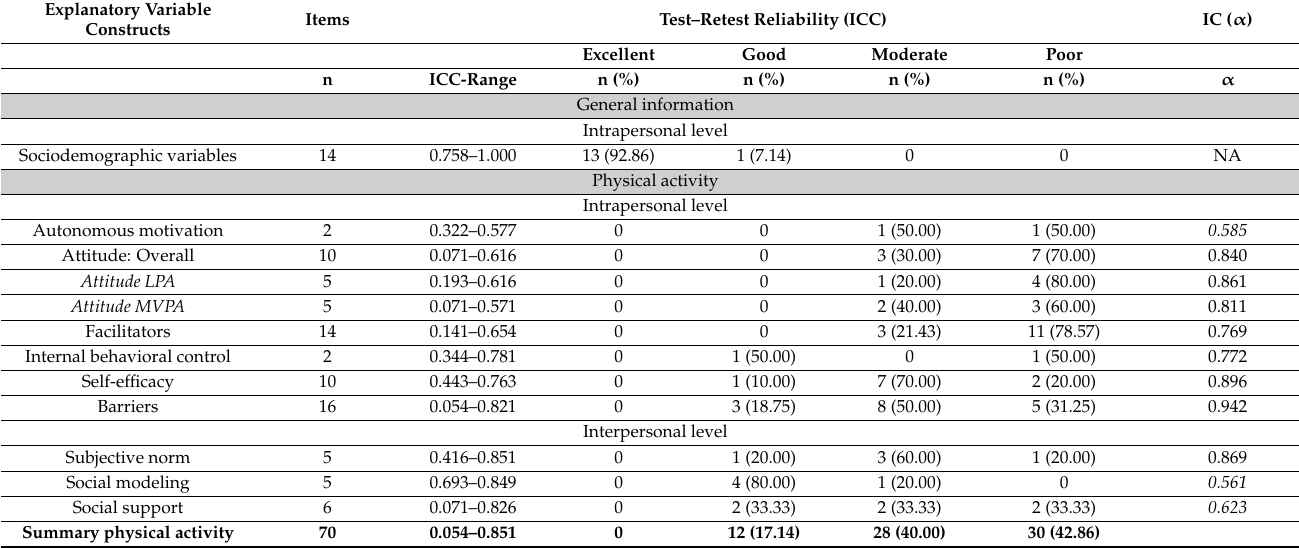
Table 2. Summary of test–retest reliability questionnaire items and internal consistency of explanatory variable